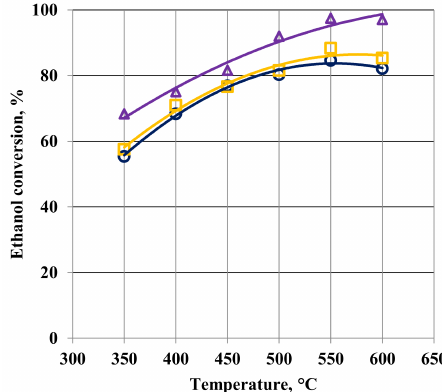
Figure 6. The influence of temperature and feed flow composition on ethanol conversion. Feed flow rate = 0.4 mol/h. Water to ethanol molar ratio in the feed: ∆ = 5, (cid:101) = 4, and o =